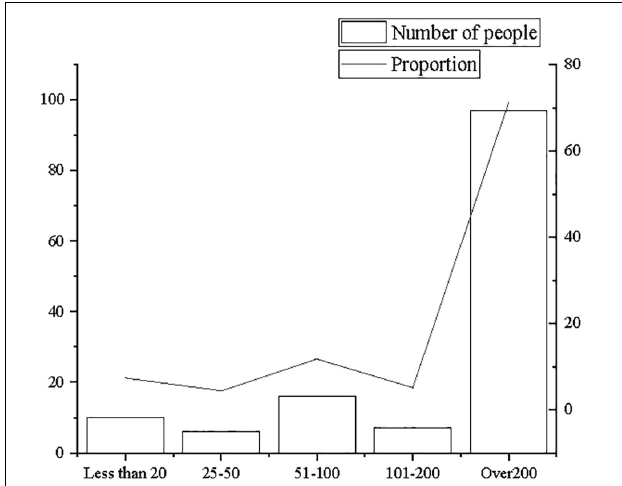
FIGURE 4 | Statistics of distribution of company